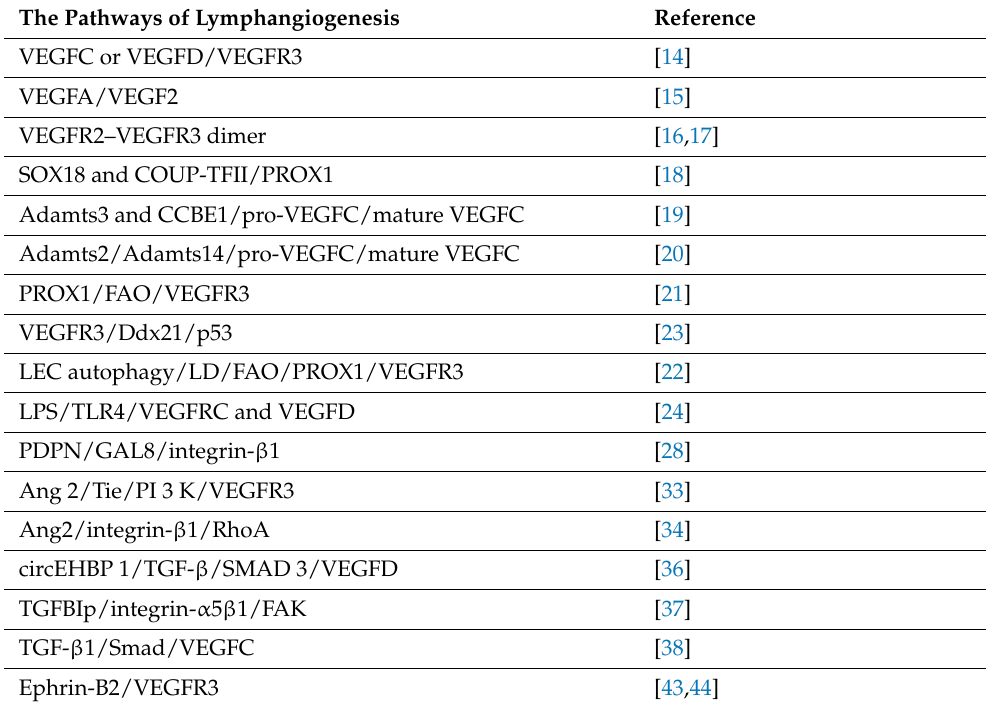
Table 1. Examples of molecules and signaling pathways that promote lymphangiogenesis.